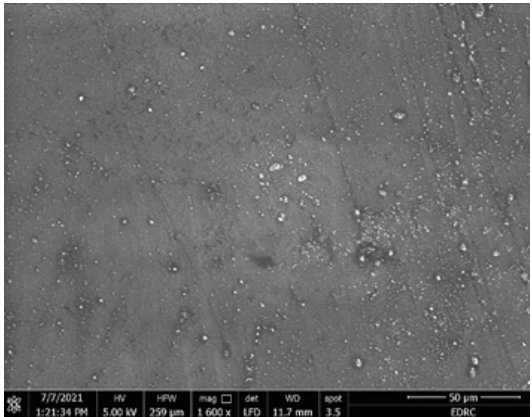
Figure 13. SEM showing the distribution of alumina nanoparticles in M2N1